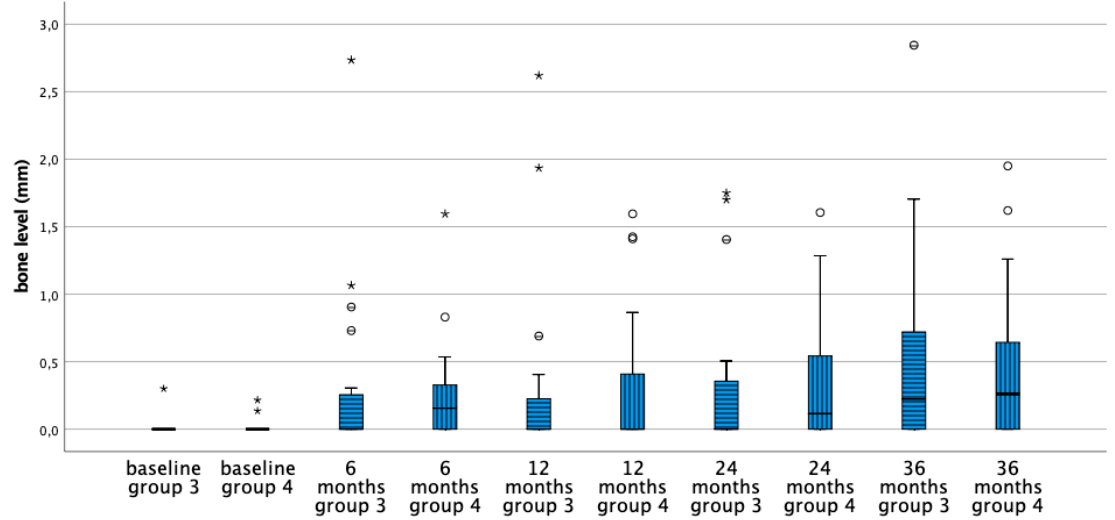
Figure 4. Boxplots representing the bone level at subsequent time points for the implants with a moderately rough neck (group 3) and minimally rough neck (group 4). * Outliers ( ≥ 3 × IQR above third quartile), ◦ suspected outliers (between 1.5 × IQR and 3 × IQR above third quartile). Between groups the subcrestally placed implants of group 2 lost no bone at all. Groups 3 and 4 showed comparable bone remodeling. Hence, implant surface roughness did not a ff ect initial nor long-term bone remodeling (Figures 4 and